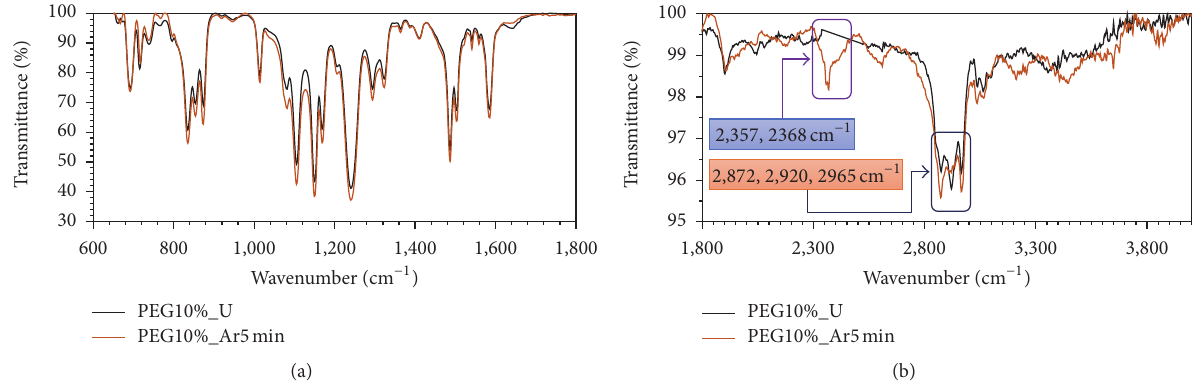
Figure 8: FTIR spectra of PSF/PEG membranes before (black) and after (orange) plasma treatment; (a) wavenumber 600 to 1,800 and (b) 1,800 to